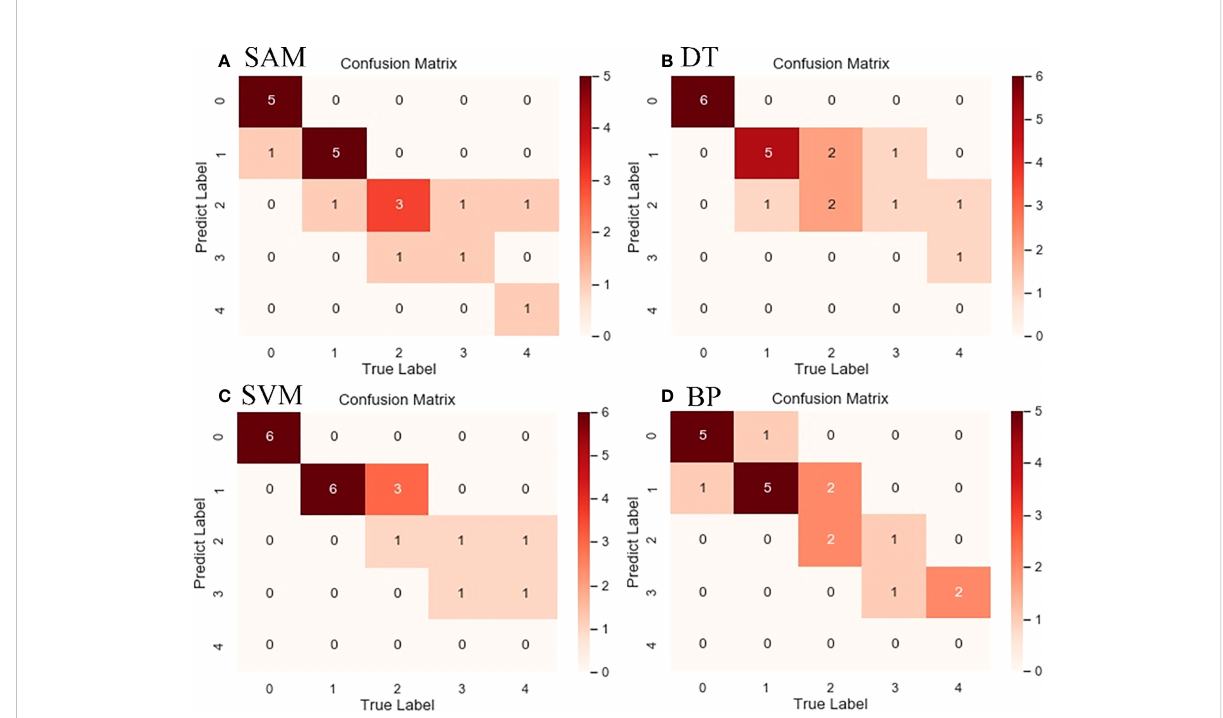
FIGURE 12 Confusion matrix of classi fi cation results offour algorithms for cotton aphid infestation at different grades in the study area. (A) SAM, (B) DT, (C) SVM, (D)